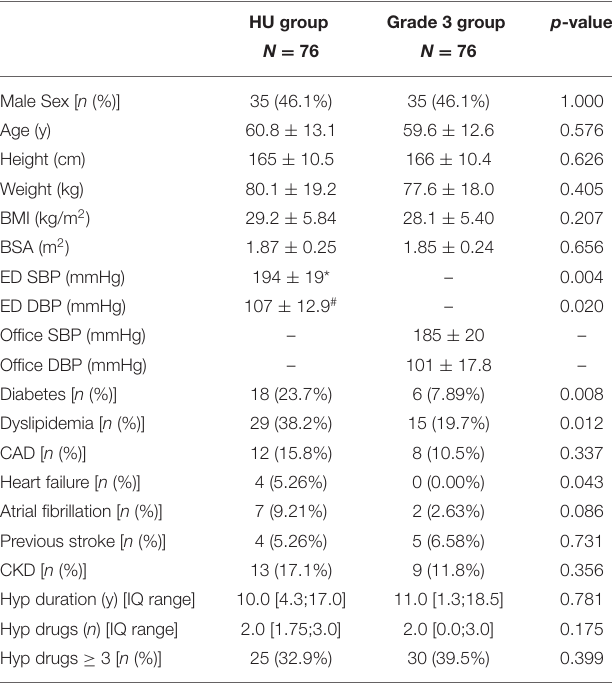
TABLE 2b | Comparison between the HU group and Grade 3 group (echocardiographic characteristics). HU